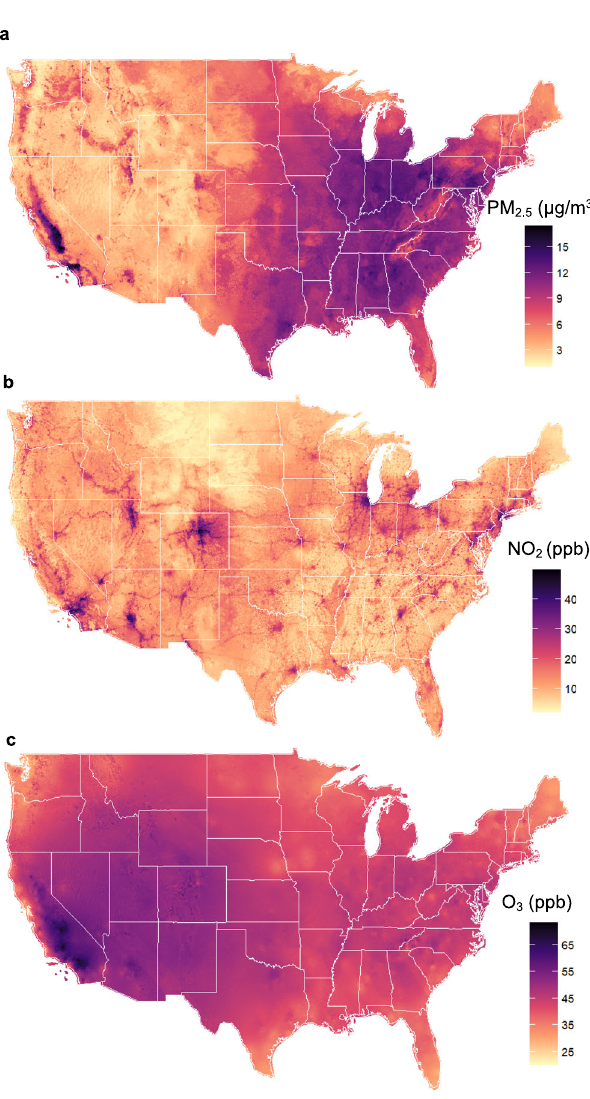
Fig. 1 Maps of the spatial distributions of air pollutants studied. The three panels present the average concentrations of a annual PM 2.5 ( μ g/m³) 16 , b annual NO 2 (ppb) 17 , and c warm-season O 3 (ppb) 18 at 1-km 2 resolution across the contiguous United States over the study period, respectively. Map was made from the census bureau shape fi le (cb_2017_us_county_500k.shp, https://www2.census.gov/geo/tiger/GENZ2017/shp/) using R software,